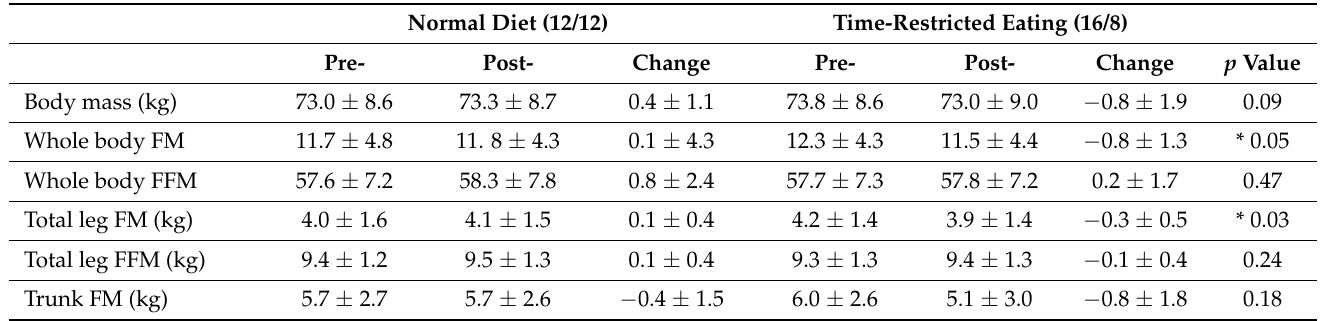
Table 4. Body Weight and Composition 1